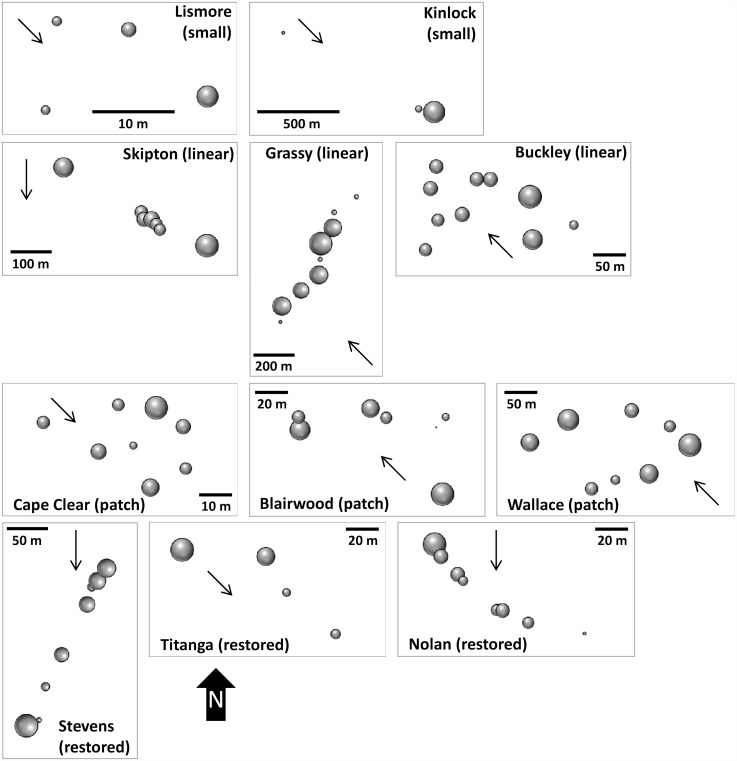
Proportional bubble plots for each Allocasuarina verticllata population to indicate the mean distance over which female trees are sampling pollen.Bubbles indicate that spatial location of each mother tree. The larger a bubble, the longer the mean distance over which pollen has been sampled. Arrows within plots indicate the predominant wind direction during flowering from the nearest meteorological station.